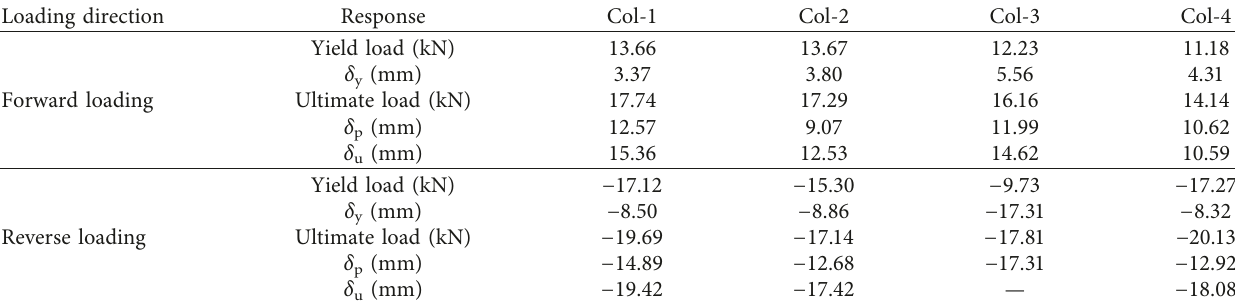
Table 2: Results of low cyclic load tests on reinforced concrete